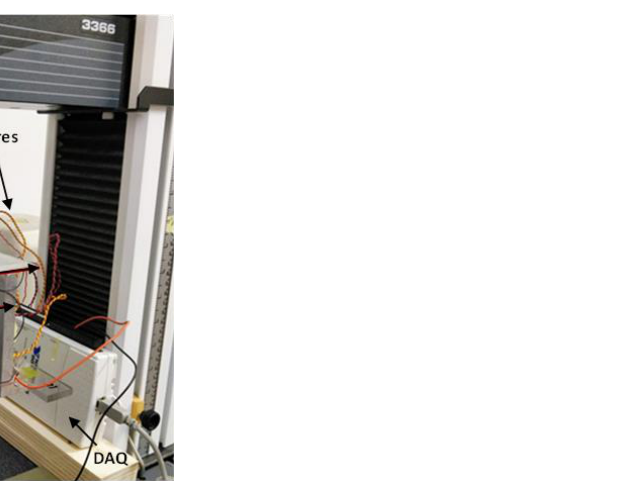
Figure 11. Set-up used to perform the different tests on the prototype with the array of strain sensors (w = 15 cm; l = 15 cm; d = 10 cm).